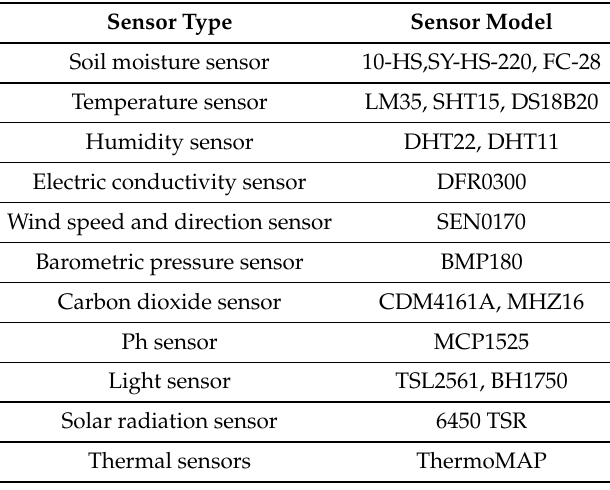
Table 2. Precision agriculture sensor